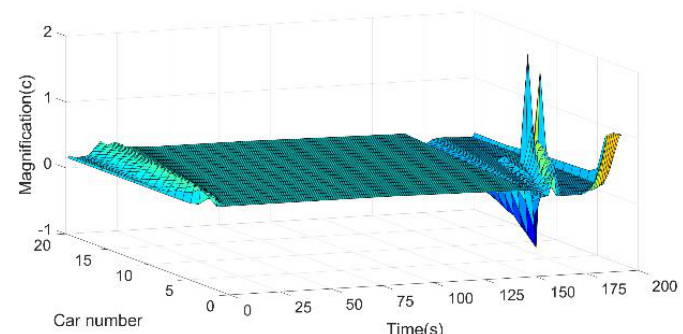
Figure 7. Vehicle current in driving situation1.